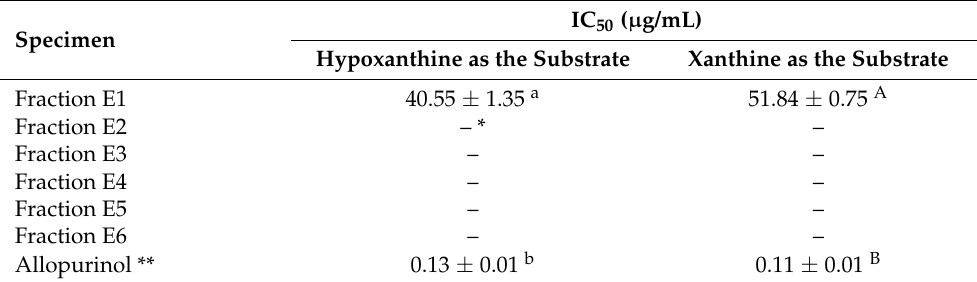
Figure 1. Xanthine oxidase inhibition effects of six fractions of leaf essential oil. ( a ) Hypoxanthine as the substrate; ( b ) xanthine as the substrate. Results are mean ± SD ( n = 3). Different letters in the figure indicate significantly different inhibition percentages between specimens at the same concentration at the level of p < 0.05 according to Scheffe’s test. Table 2. IC 50 values of six fractions against xanthine